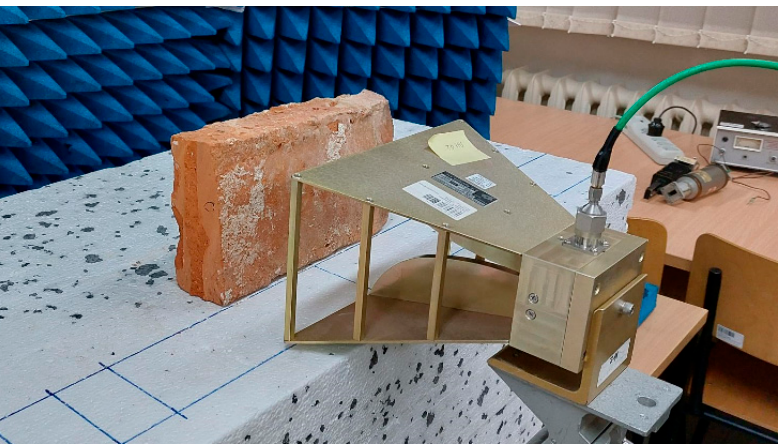
Figure 3. Close up of the laboratory setup during microwave measurements: double ridge antenna, a brick, styrofoam stand and microwave absorbers.